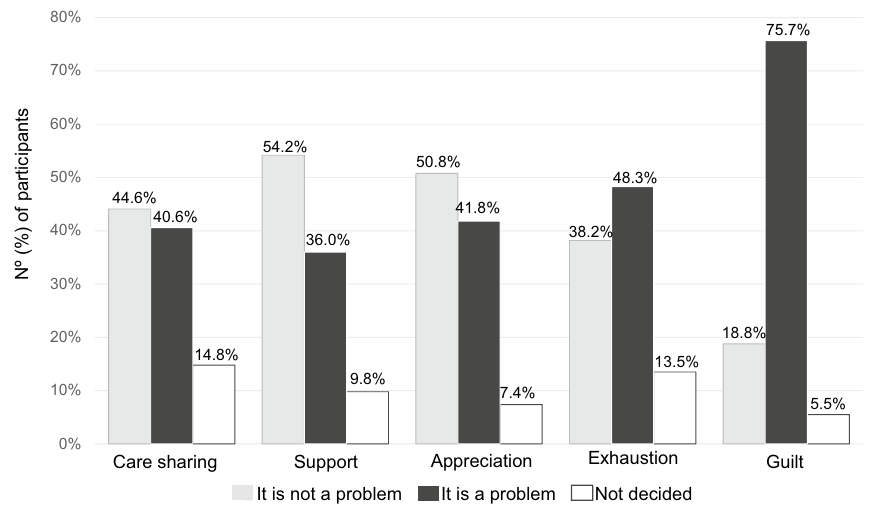
Figure 2. Assessment of diabetes-specific emotional burden related to diabetes care in caregivers of children and adolescents with a previous diagnosis of type 1 diabetes during the COVID-19